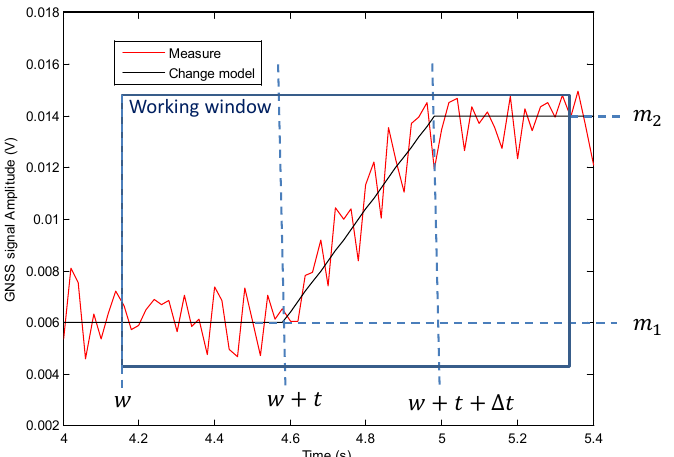
Figure 4. Signal model in a working window. m 1 and m 2 represent the mean values of the GNSS signal amplitudes when the ellipses are on land and on water,